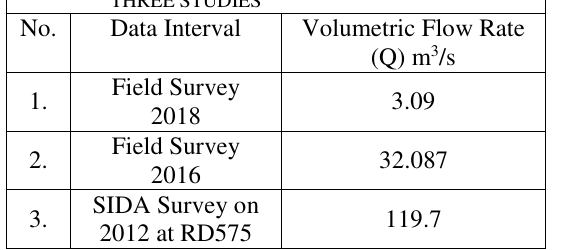
FIG. 6: LAYOUT OF A MINI HYDRO POWER PLANT SITE LAYOUT (ADAPTED FROM